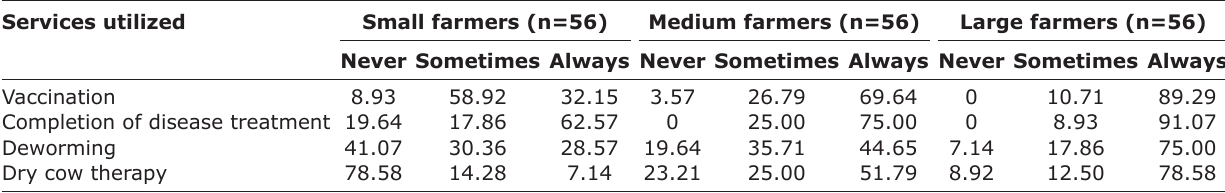
Completion of disease treatment 19.64